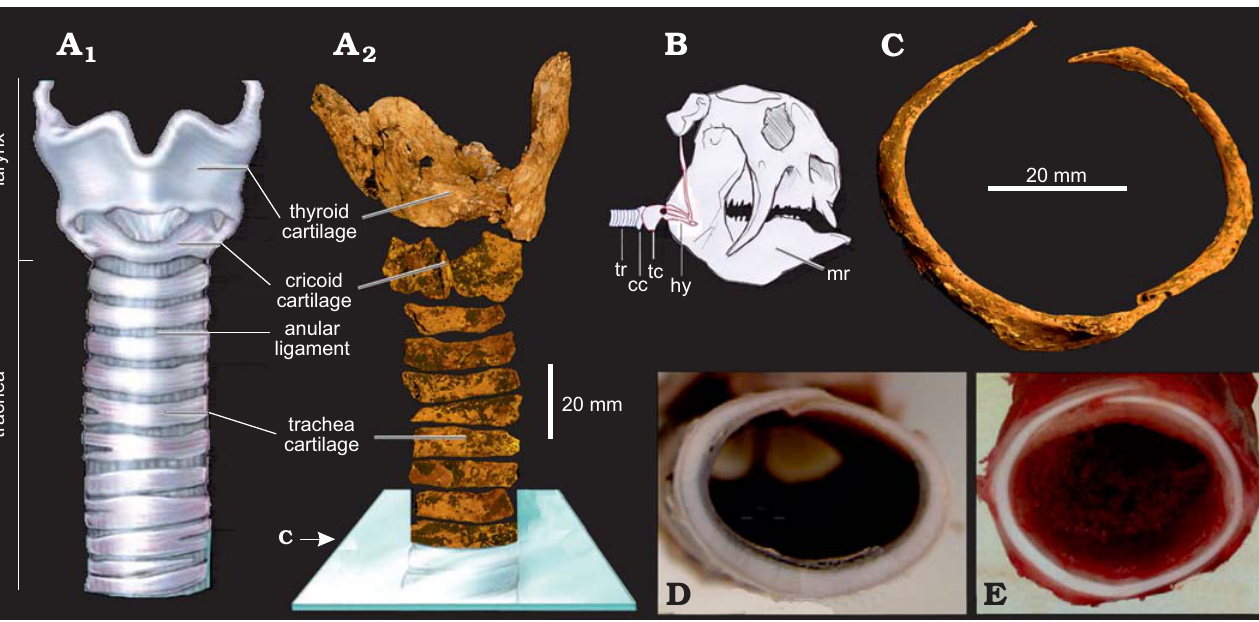
Fig. 3. Cartilages present in the neck of glyptodont mammal Panochthus sp. compared with Recent California sea lion and domestic pig. A . Thyroid, cri- ), Panochthus sp. (A ). B . Explanatory drawing of the Panochthus sp. skull in lateral coid, and tracheal cartilages in ventral view; generalized mammal (A 1 2 view, with hyoid apparatus and tracheal rings. C–E . Tracheal rings in anterior view. C . Panochthus sp. (MHM-P 87). D . California sea lion Zalophus californianus Lesson, 1828. E . Domestic pig Sus scrofa domestica Linnaeus, 1758. A, modified from Martínez and Turpín 2015; D, E, modified from Moore et al. 2014. Abbreviations: cc, cricoid cartilage; hy, hyoid apparatus; mr, mandibular rami; sk, skull; tc, thyroid cartilage; tr, tracheal